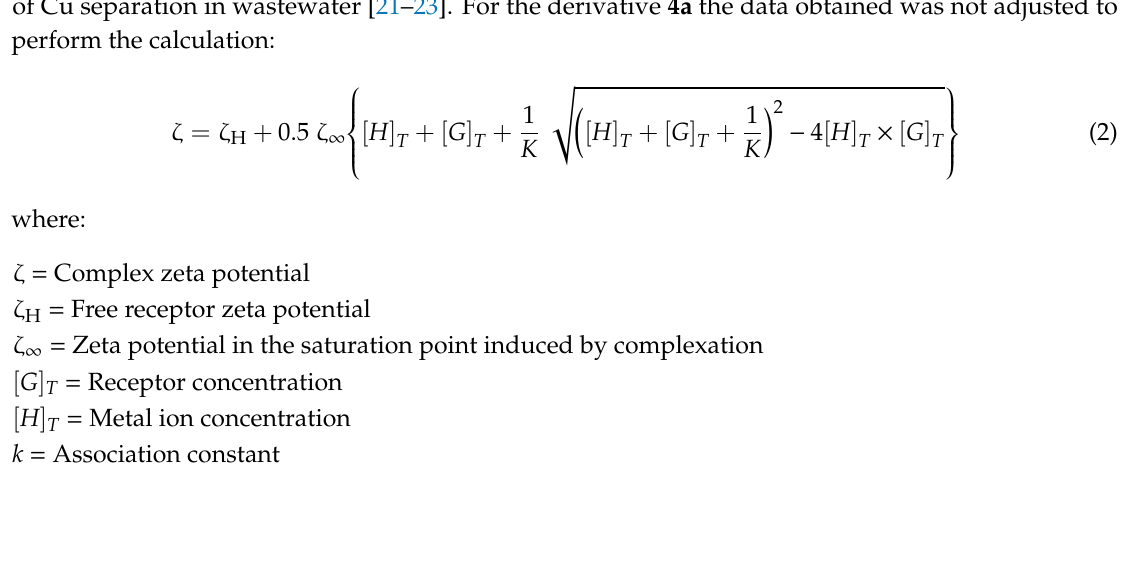
Table 3. The binding constants ( k f ) of Cu 2+ with the derivative 1a-5a.